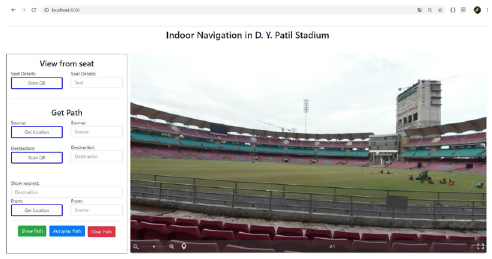
Figure 4. System User